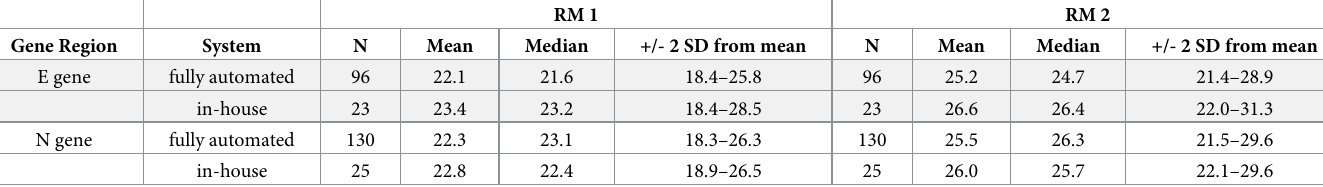
Table 4. Statistical analysis of Ct value distribution per gene region and for fully automated systems and in-house assays for RM 1 and RM 2.